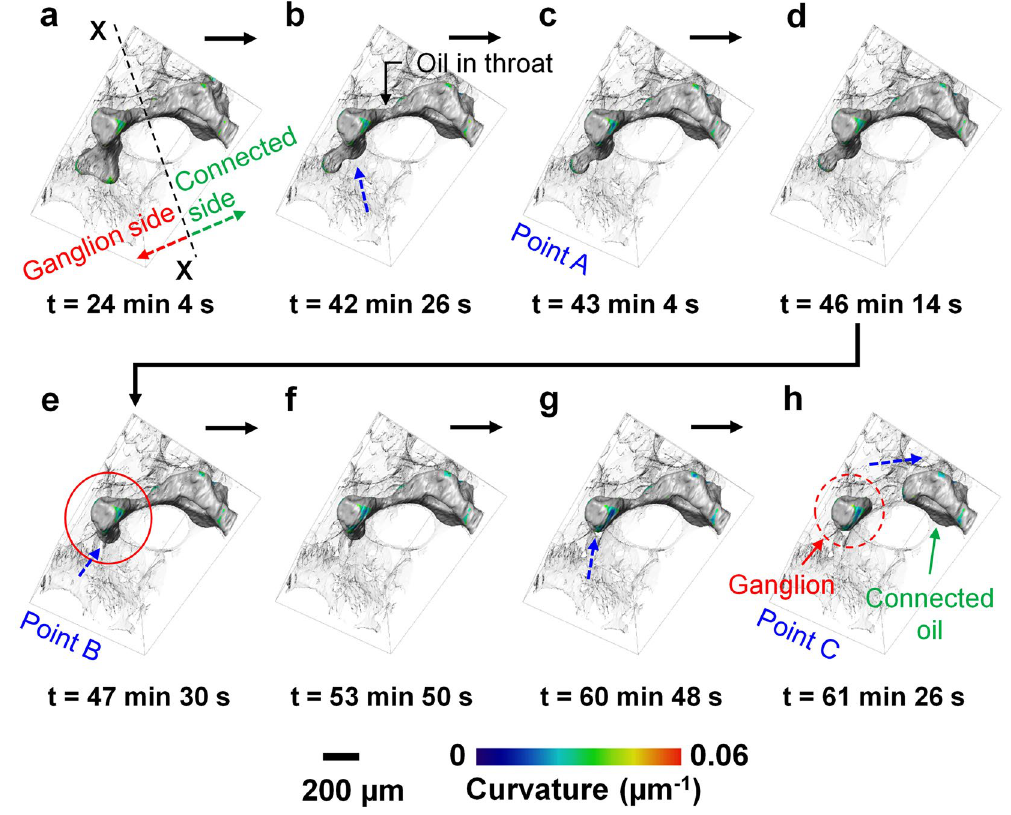
Figure 1. Snap-off during imbibition in a throat between two adjacent pores. Various times during brine injection showing oil progression and trapping in a water-wet Ketton rock sample: ( a ) t = 24 min 4 s (injected volume = 1.077 µ L), ( b ) t = 42 min 26 s (injected volume = 1.899 µ L), ( c ) t = 43 min 4 s (injected volume = 1.927 µ L), ( d ) t = 46 min 14 s (injected volume = 2.069 µ L), ( e ) t = 47 min 30 s (injected volume = 2.126 µ L), ( f ) t = 53 min 50 s (injected volume = 2.409 µ L, ( g ) t = 60 min 48 s (injected volume = 2.721 µ L), and ( h ) t = 61 min 26 s (injected volume = 2.749 µ L). The rock and brine are shown semi-transparent and transparent respectively for effective visualization. The dashed blue arrows indicate the approximate direction of interface migration. Points A–C show the events marked in Fig. 2. Time ‘t = 0’ denotes the start of the imbibition process (after acquiring the first tomographic image in imbibition). Time (t) represents the end of each tomographic image